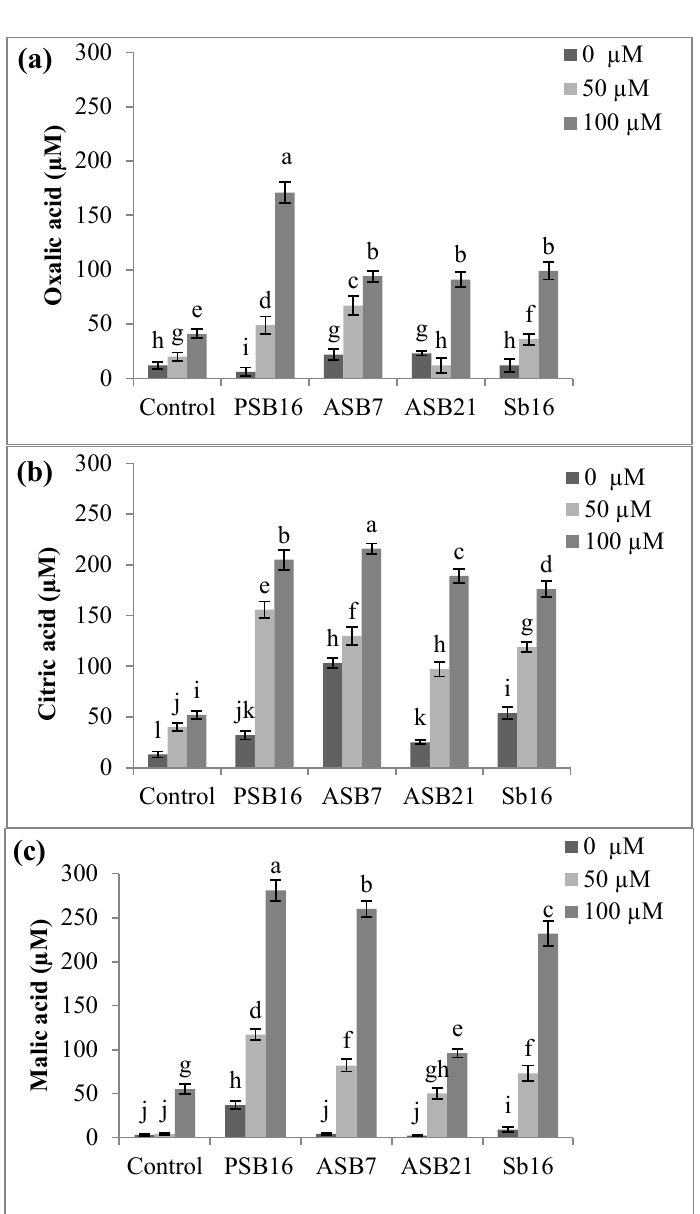
Figure 3. Effects of Al on the release of organic acids by rice plant and or PGPB: ( a ) oxalic; ( b ) citric; and ( c ) malic acid. Where, PSB 16 = Bacillus sp., Sb16 = Stenotrophomonas maltophila , ASB7 = Burkholderia thailandensis , ASB21 = Burkholderia seminalis. Means within the same column followed by the same letters are not significantly different at p < 0.05. Bars indicate standard error, n =